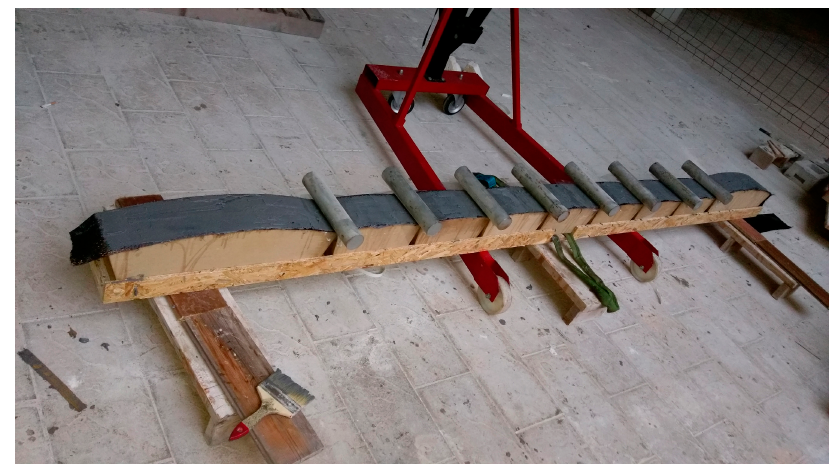
Figure A6. Steel cylinders weighing down the butyl tape.